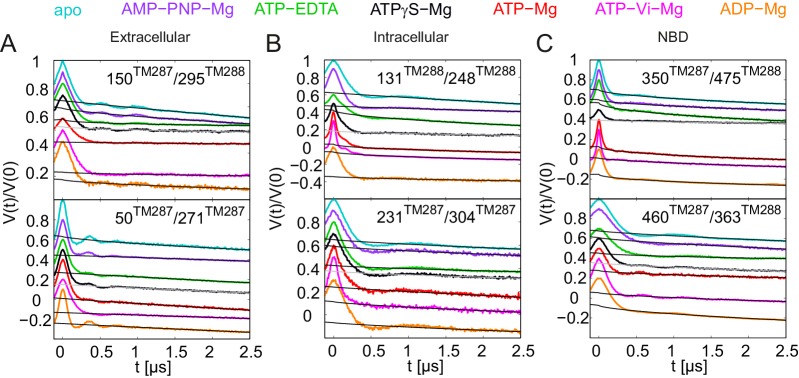
Primary DEER traces of spin-labeled pairs in wildtype TM287/288.Q-band DEER traces [V(t)/V(0)] with the fitted background using homogeneous stretched exponential decay with dimensions of 1.5–3 for the six spin-labeled pairs engineered into wildtype TM287/288. Color code as in Figure 2. (A and B) Extracellular pairs 150TM287/295TM288 and 50TM287/271TM287. (C and D) Intracellular pairs 131TM288/248TM288 and 231TM287/304TM287. (E) NBD pair 460TM287/363TM288 monitoring the consensus site. (F) NBD pair 350TM287/475TM288 monitoring the degenerate site. The data of the apo and AMP-PNP-Mg states of the four pairs 150TM287/295TM288, 131TM288/248TM288, 460TM287/363TM288, 350TM287/475TM288 in the wildtype transporter are taken from (Hohl et al., 2014).